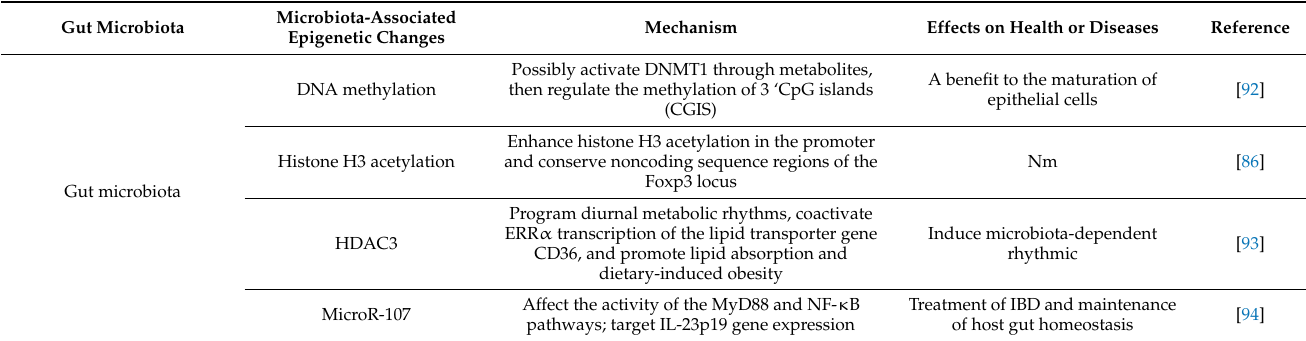
Table 2. Mechanisms of gut microbiota that induce host epigenetic